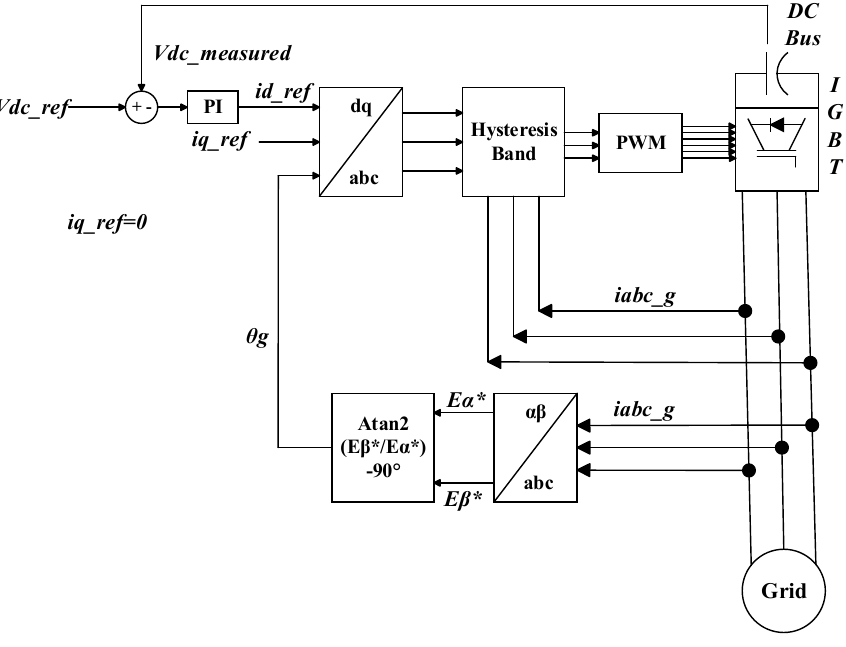
Figure 1. The block diagram of proposed method for